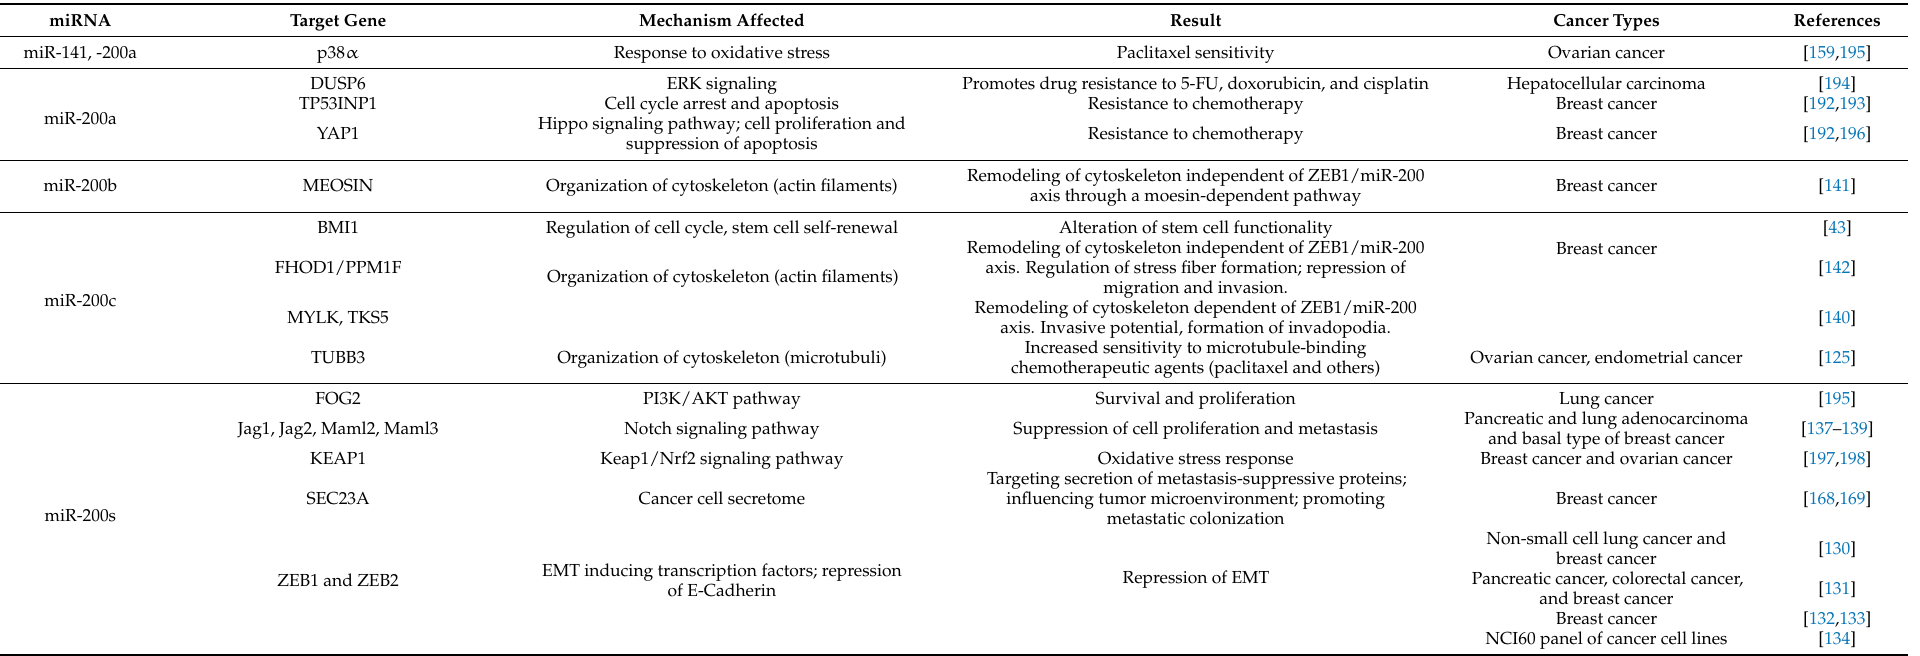
Table 3. Summary of miR-200s, target genes, and intervening mechanism in multiple cancer